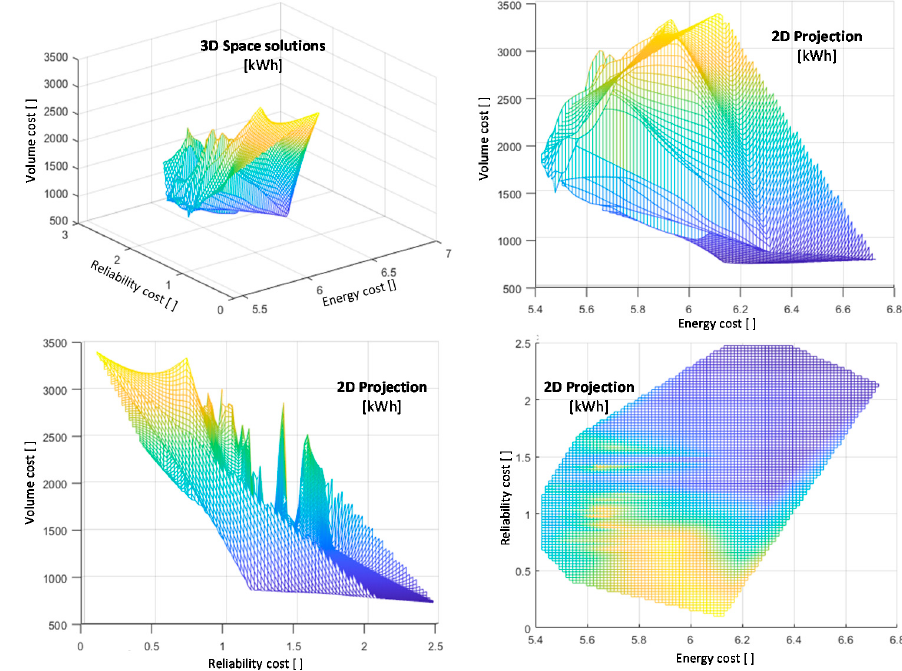
Figure 13. Design mapping on WLTC Cycle.